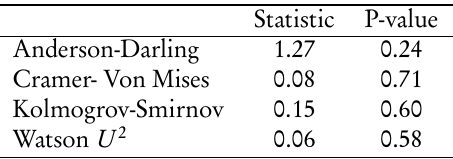
The test of the fitted PFD models to data